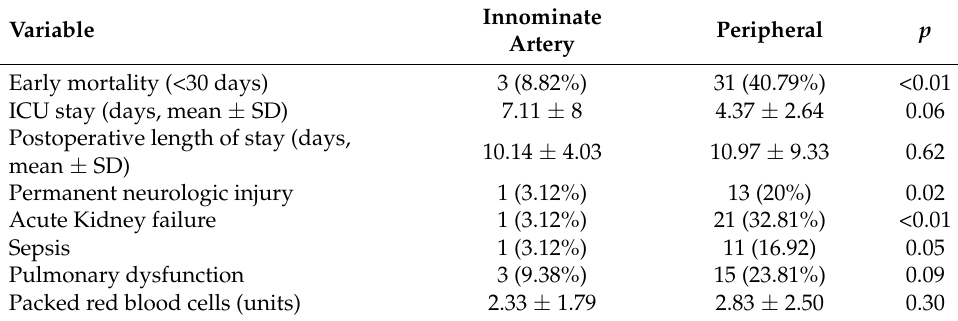
Table 4. Postoperative